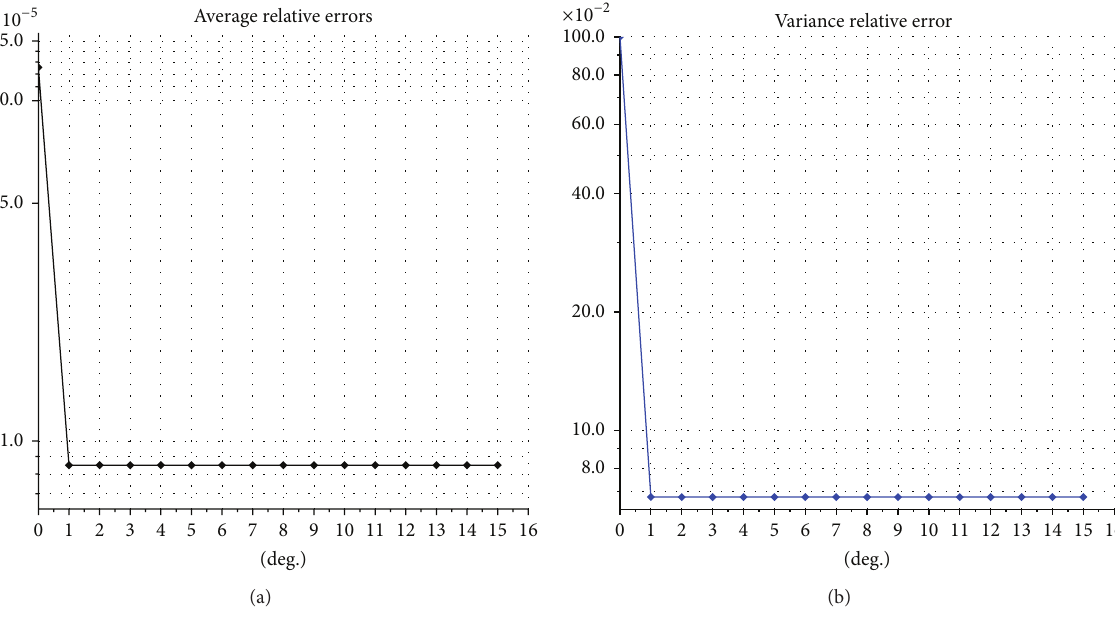
Figure 16: Semilogy scale plot of the relative errors RE (𝑝) MEAN (a) and RE (𝑝) VAR (b) computed for 𝑝 = {0,1,2,...,15} with higher precision at computing {𝑅 𝑇 , 𝑗} 𝑁 𝑗=1 , for 𝑇 = 1 . Moreover, the CIR interest rate parameters are 𝛼 = 0.1 , 𝛽 = 0.2 , 𝜎 = 0.15 , and 𝑅 0 = 110 .